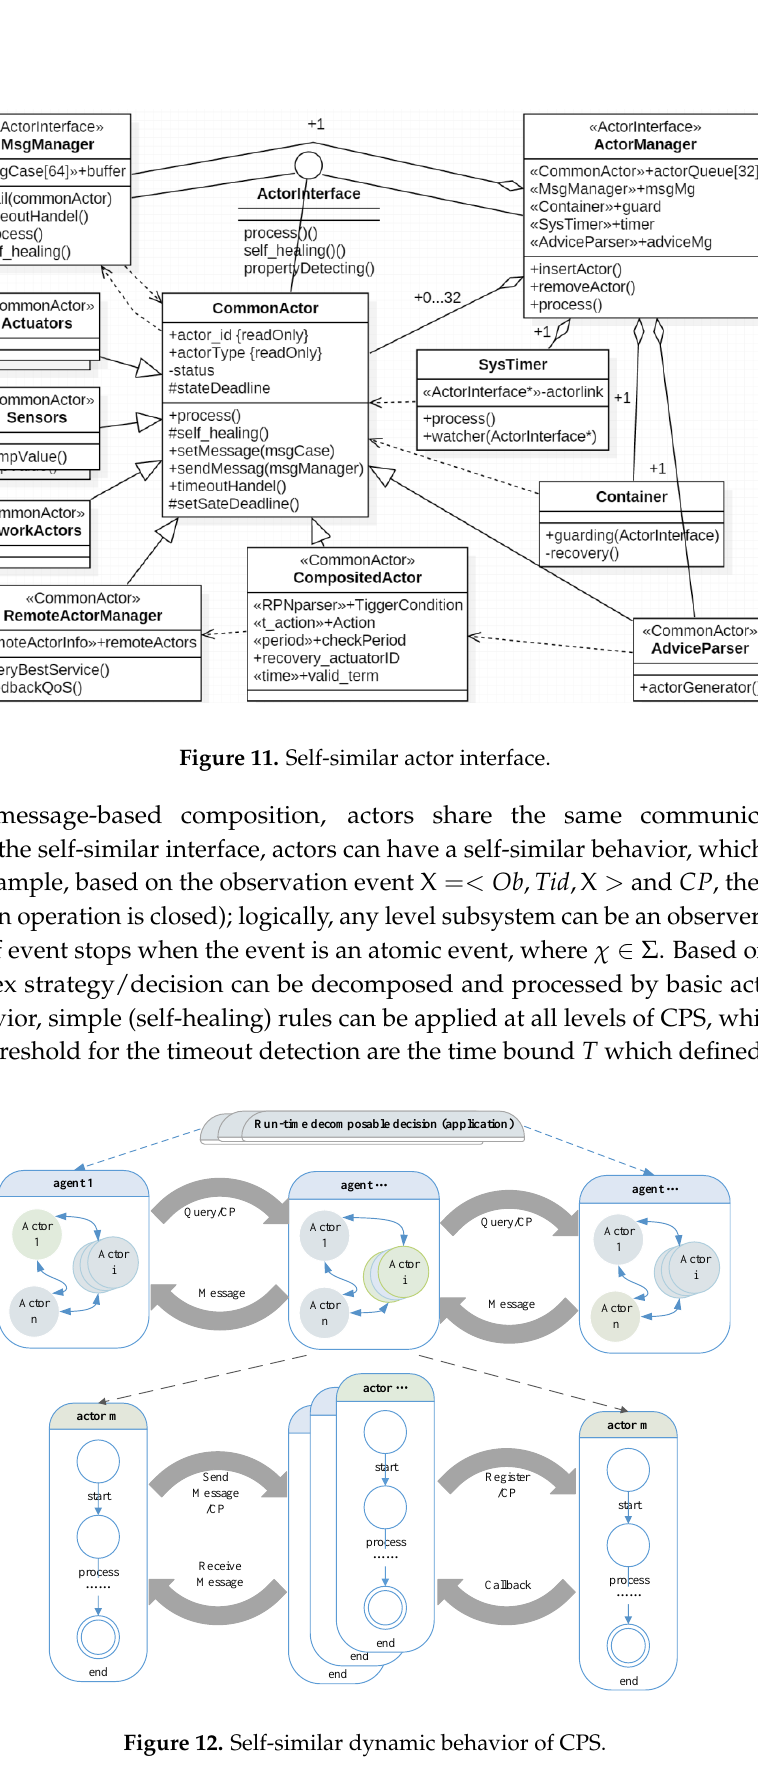
Figure 12. Self-similar dynamic behavior of CPS.